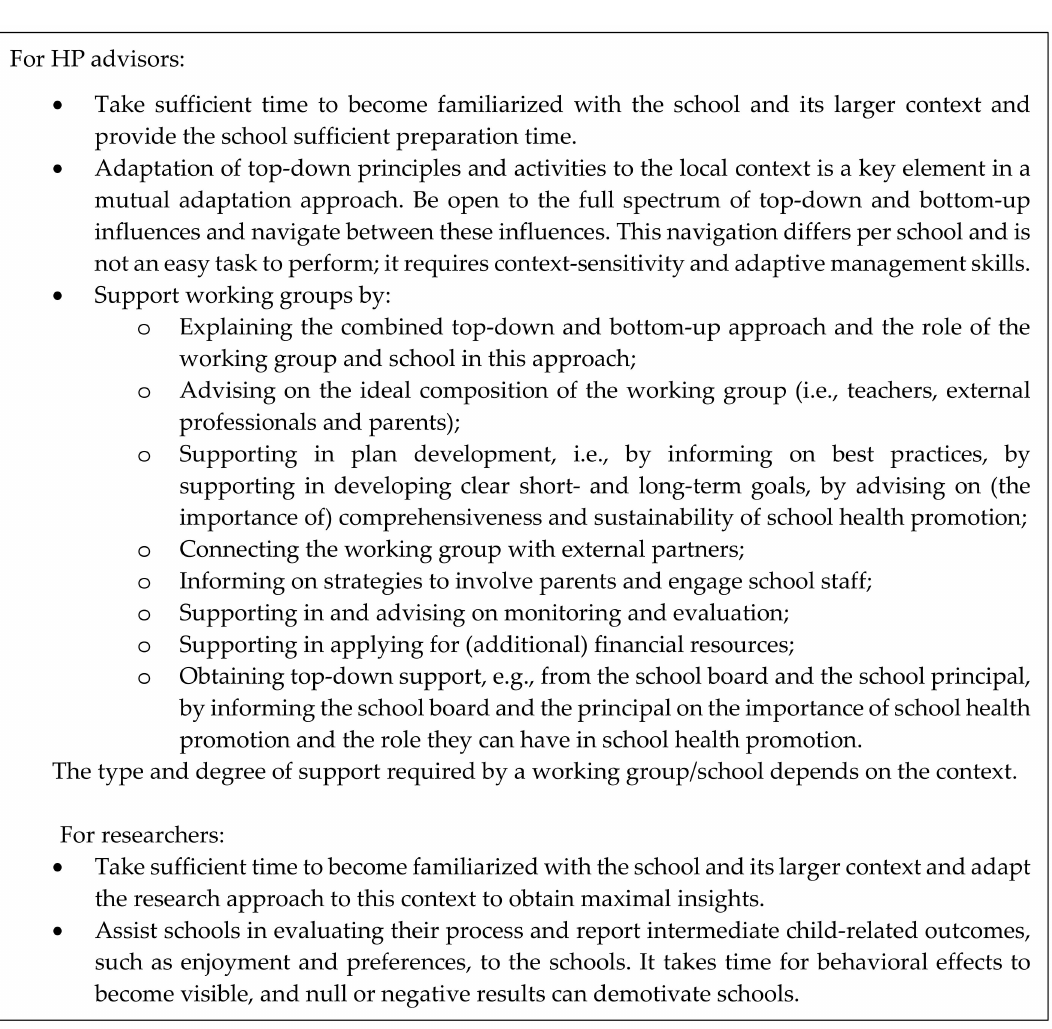
Figure 5. Important lessons learned from implementing the KEIGAAF